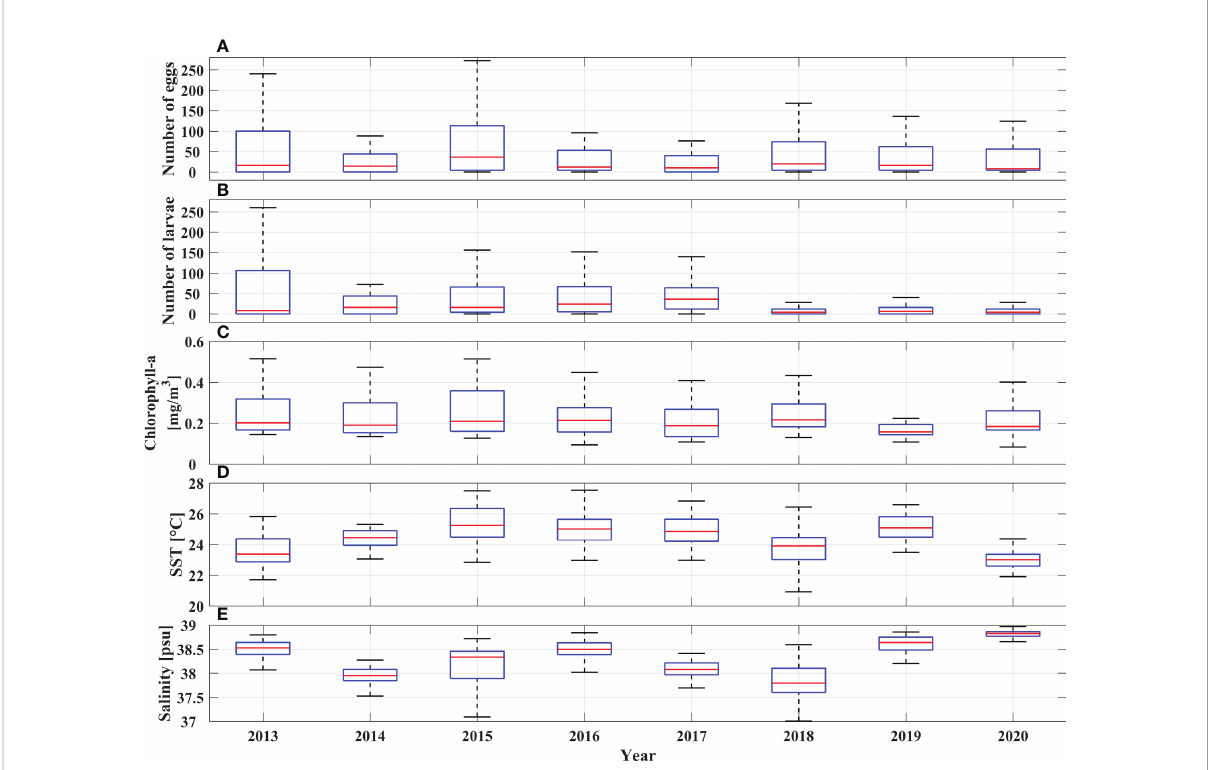
FIGURE 4 Boxplots of Adriatic anchovy egg (eggs/m 2 ) (A) and larval abundance (larvae/m 2 ) (B) collected through the summer surveys and the associated values of satellite Chlorophyll-a (mg/m 3 ) (C) , satellite sea surface temperature (°C) (D) and modeled salinity (E) for the period 2013 -